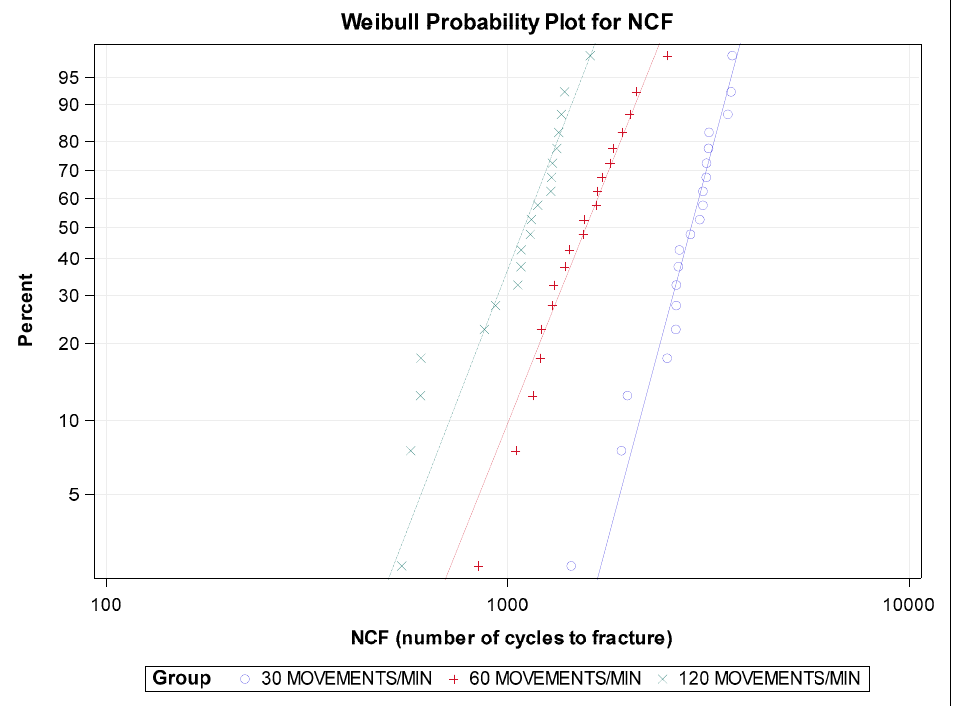
Figure 7. Weibull probability plot of the NCF.